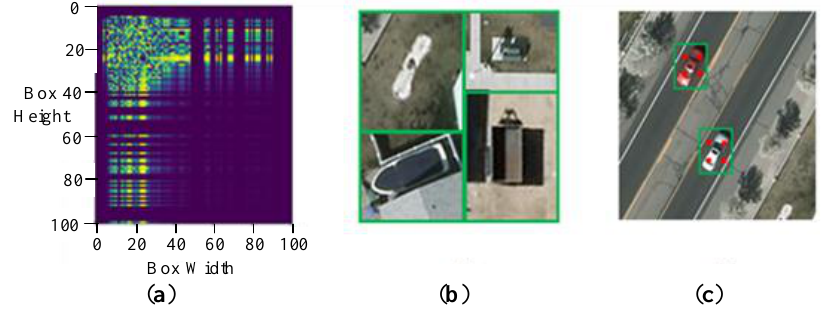
Figure 1. Picture information in the VEDAI data set: ( a ) VEDAI image Scale distribution, ( b ) similar vehicles, ( c ) FCOS ground truth.